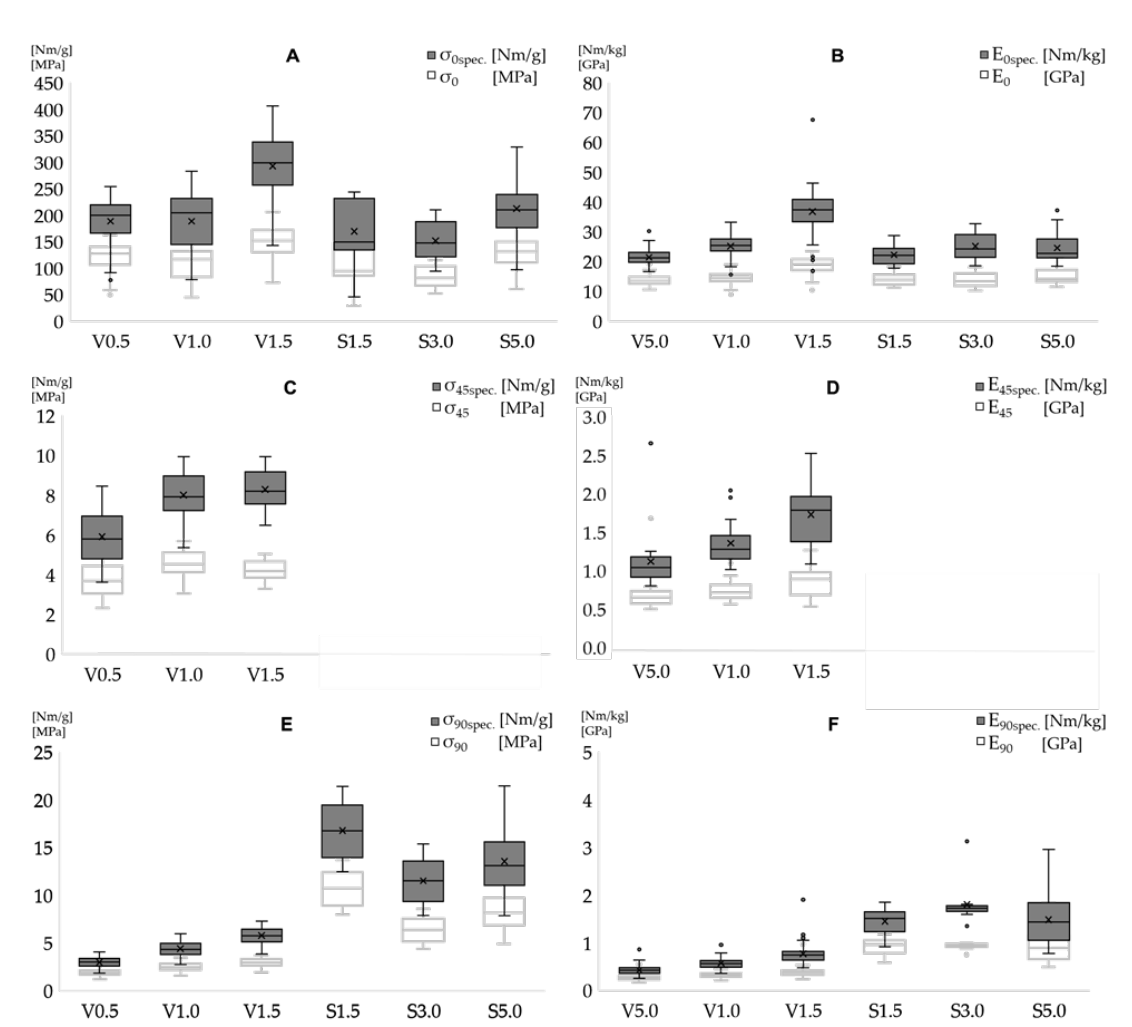
Figure 2. Boxplots of strength and stiffness as well as specific strength and stiffness for the respective thickness groups (V0.5, V1.0, V1.5, S1.5, S3.0 and S5.0): ( A ) strength at 0° load angle, ( B ) stiffness at 0° load angle, ( C ) strength at 45° load angle, ( D ) stiffness at 45° load angle, ( E ) strength at 90° load angle and ( F ) stiffness at 90° load angle.